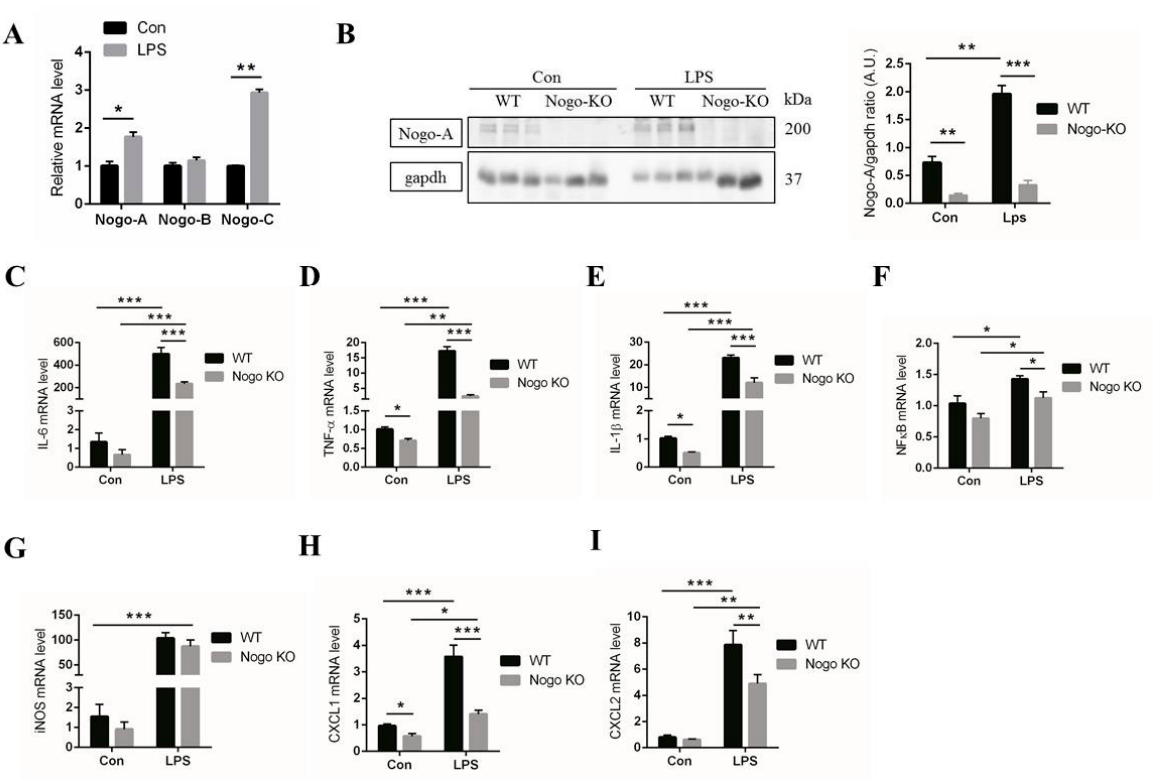
Figure 2. Nogo deficiency inhibits pro-inflammatory gene expression in BMDM after lipopolysaccharide (LPS) treatment. ( A ) Nogo-A and C, but not Nogo-B, are upregulated in LPS-treated bone marrow-derived macrophages (BMDM) compared with the levels in control BMDM ( n = 3). ( B ) IB data of control and LPS-treated BMDM. Nogo-A was increased in response to LPS treatment in WT BMDM compared with the levels in Nogo-KO BMDM ( n = 3). ( C – I ) mRNA levels of pro-inflammatory factors including IL-6, TNF- α , IL-1 β , nuclear factor kappa B (NF- κ B), iNOS, CXCL1, and CXCL2 in control and LPS-treated WT and Nogo-KO BMDM ( n = 4). In all, 30 µ g of protein was used in IB. GAPDH was used for normalization. Data are shown as the mean ± standard error of the mean. Statistical significance was determined using Student’s t -test. Data are denoted by asterisks, where * p < 0.05, ** p < 0.01, and *** p < 0.001.